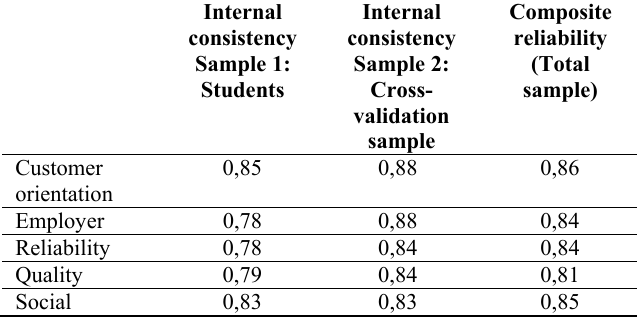
Table 5: Reliability assessment